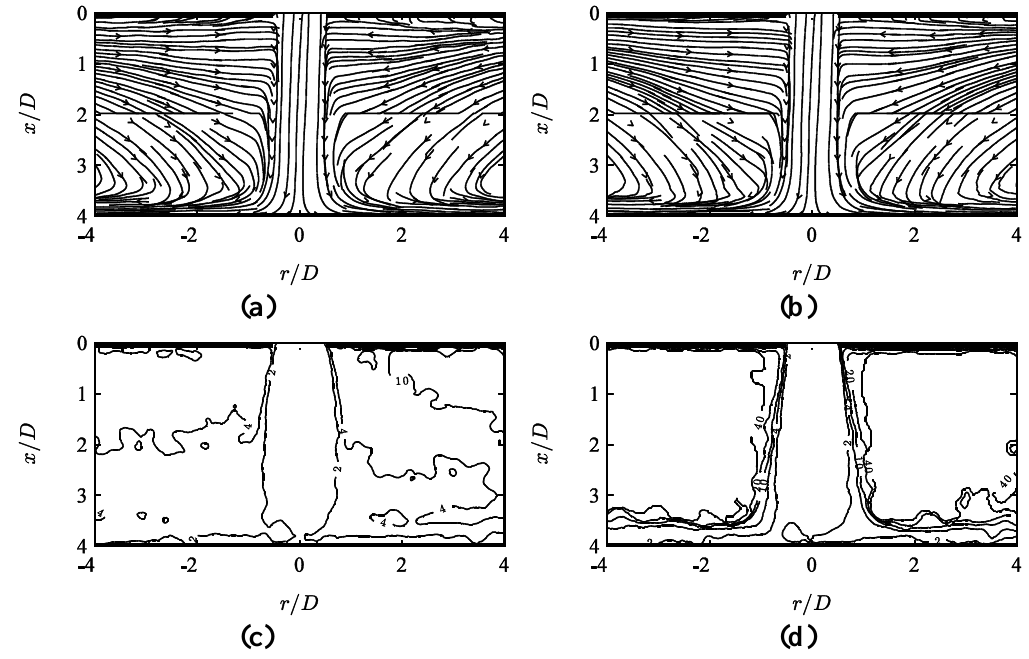
Figure 5. MPS PIV results with (a,c)  (b,d)  = 0.2 px and p  +  for data acquired at  /  s